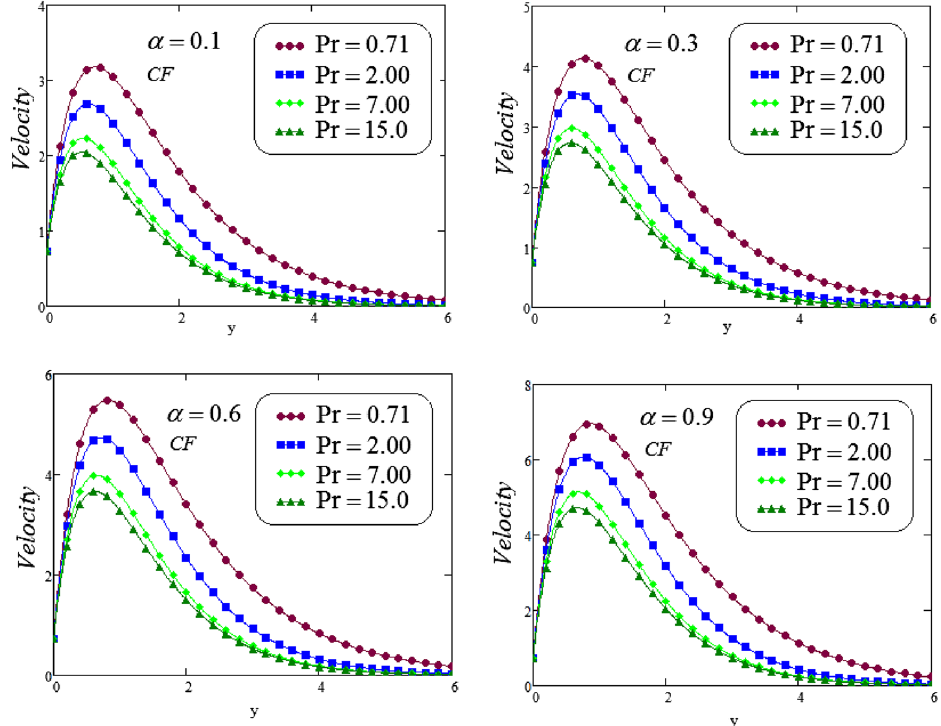
Figure 10. Representation of second grade fluid velocity via CF for distinct values of Pr